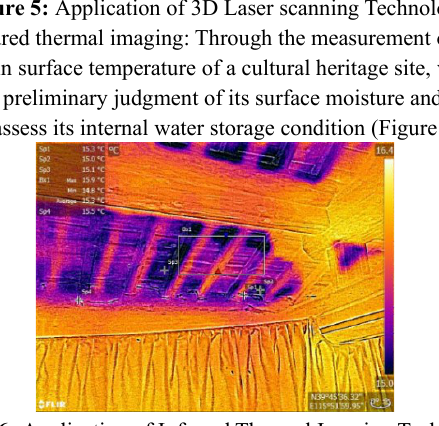
Figure 6: Application of Infrared Thermal Imaging